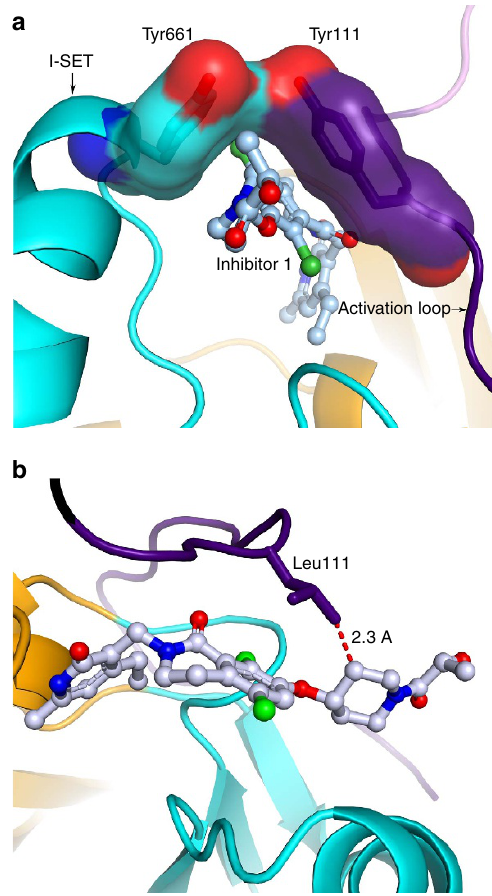
Figure 8 | Inhibitor binding and the mechanism of drug resistance. ( a ) Ligand accesses the cavity enclosed by the contact between Tyr111 and Tyr661 in the active PRC2. When either of these two sidechains is mutated by a smaller one, the cavity would shrink in size posing a steric conflict for the ligand recognition. ( b ) Modelling of Y111L shows the introduction of the steric conflict with the ligand. Colour notation is same as in Fig.